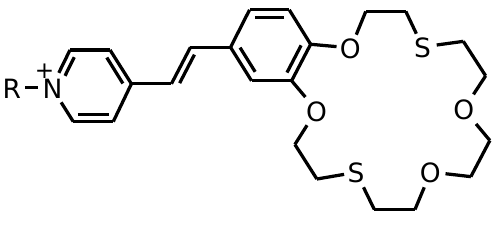
Figure 8. The structure of the amphiphilic pyridinium benzodithia-18-crown-6 dye ( 1 ).